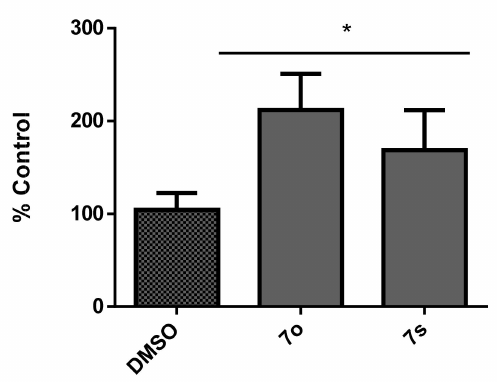
Figure 4. Percentage of the normalized caspase 3/7 activity in AGS cells after 48 h of exposure to the selected compounds at 12.5 µ M. * Significantly different from control for p <